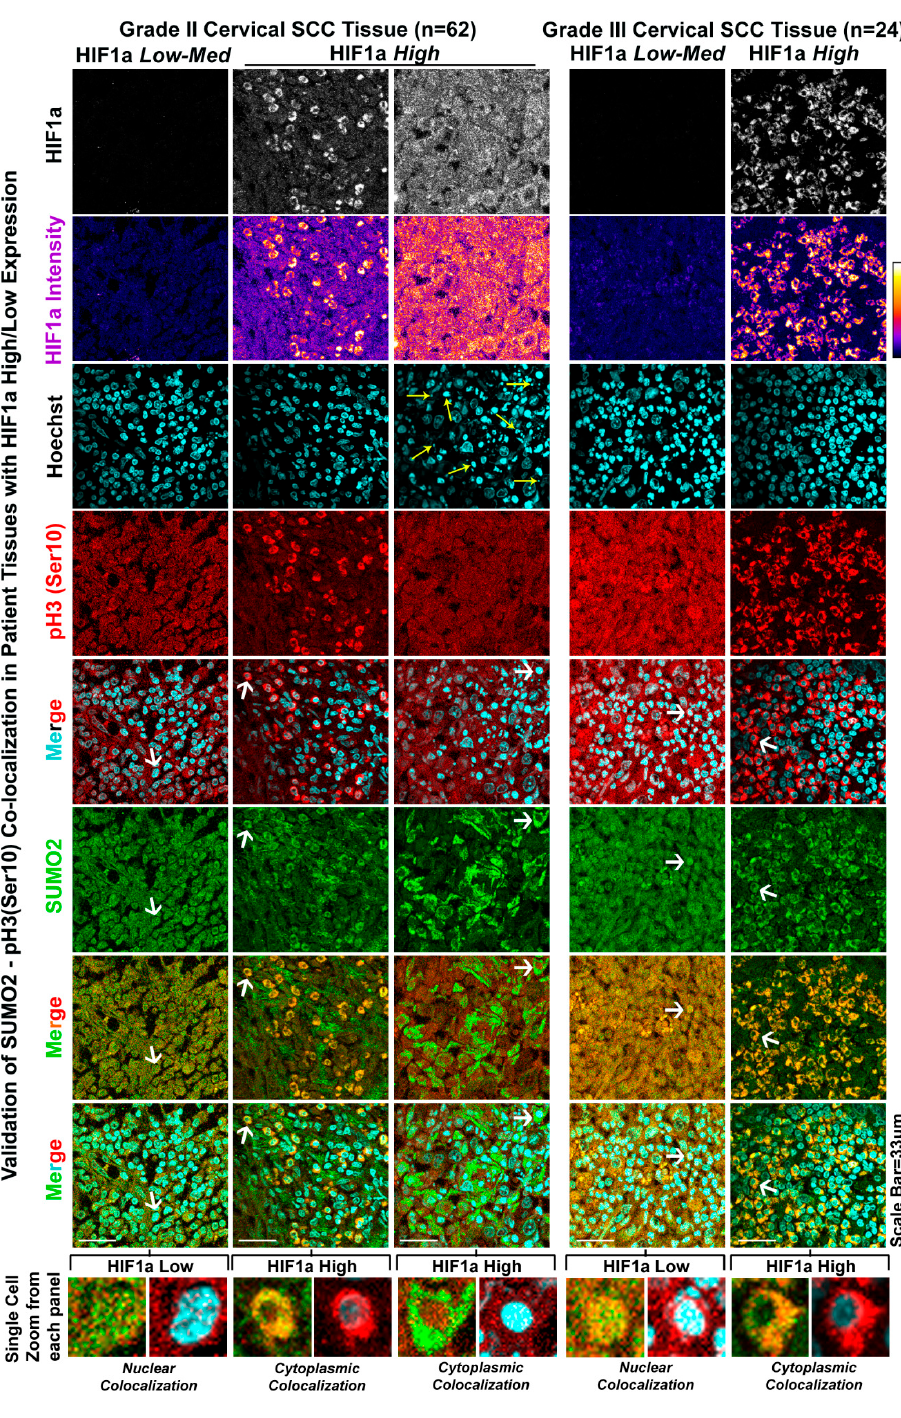
Figure 7. High HIF1a-expressing regions in cancer tissues validate the role of hypoxia in cytoplasmic sequestration of SUMO2-pH3(Ser10). Grade II and III cervical squamous cell carcinoma tissues showed hypoxic (HIF1a high) and normoxic (HIF1a low–medium) areas within the same block. Cytoplasmic localization of pH3(Ser10) and SUMO2 was observed in HIF1a-positive cells. On the contrary, HIF1a low to medium expressing regions showed appreciable nuclear colocalization. White arrowheads indicate the single cell with zoomed images in the lowermost panel. Yellow arrows indicate the condensed chromatin associated with apoptosis in acute hypoxic regions. See related Supplementary Figures S10–S15 for extended validation on uterine cervical cancer grade I, grade III and brain, breast colon, pancreatic, skeletal muscle, liver, and stomach cancer